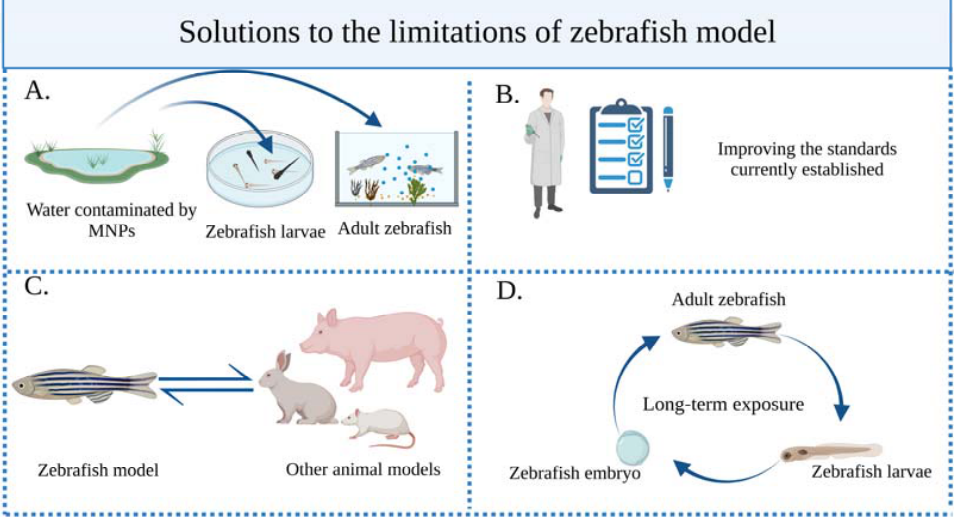
Figure 5. Solutions to the limitations of zebrafish. ( A ) To optimize the zebrafish exposure experiments, larval or adult zebrafish should be exposed to real MNPs in contaminated water. ( B ) The current unified experimental operating procedures and standards must be strictly followed, and researchers still need to promote the construction of standards, so that the toxicity evaluation of zebrafish as a model organism can be more perfect. ( C ) The mutual verification mechanism for animal models must be strengthened. ( D ) Long-term exposure experiments should be carried out to expose adult zebrafish to MNPs over a long period of time and there should be generation studies from adult fish to offspring, and then to offspring adult respawning to comprehensively investigate MNP toxic mechanisms.